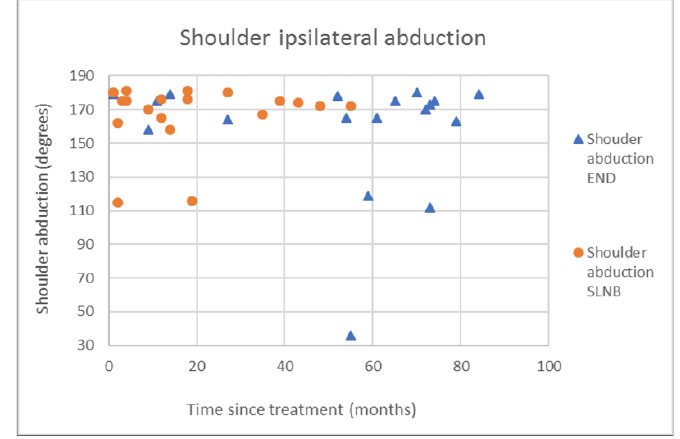
Figure 7. Shoulder ipsilateral abduction in relation to time since treatment.